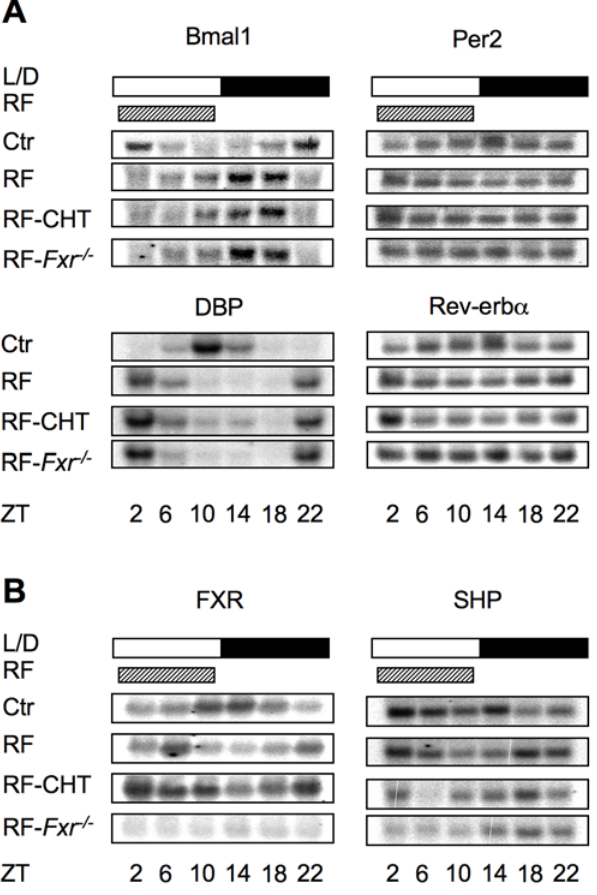
components in liver is not affected by bile acid level in mice. A. Expression of core circadian clock genes in liver is reversed by RF, which is not altered in either the cholestyramine-treated (RF-CHT) or Fxr 2 / 2 (RF- Fxr 2 / 2 ) groups. B. Expression of FXR and SHP showed circadian regulation, which is altered by RF.